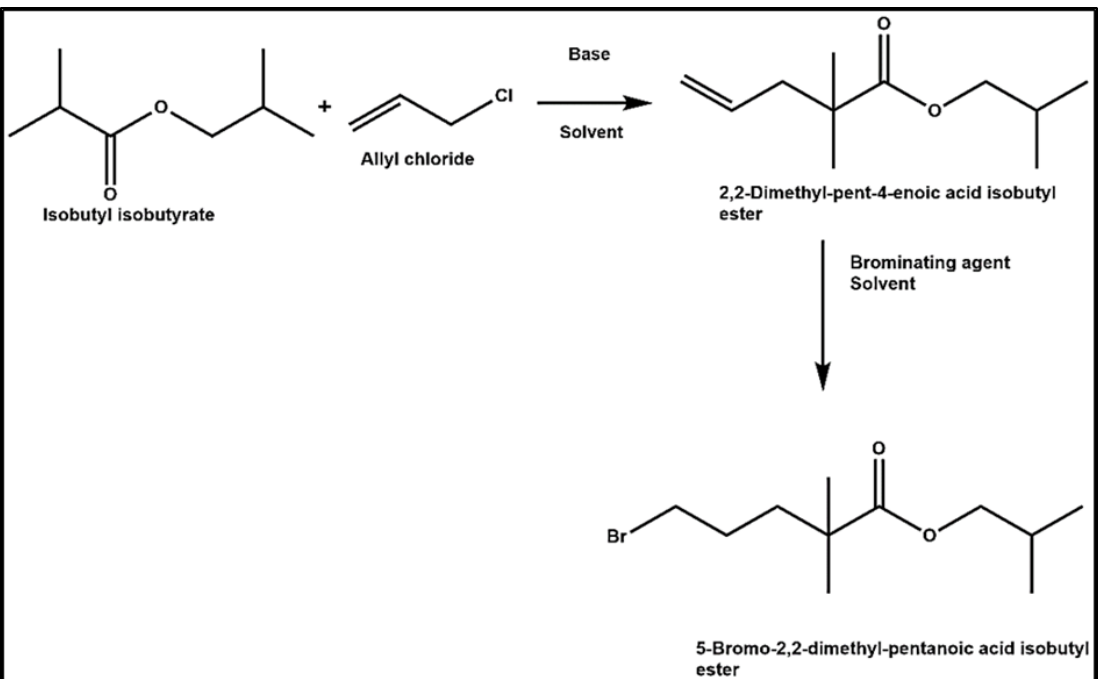
Figure 2. Reaction mechanism for the formation of 5-Bromo-2,2-dimethyl-pentanoic acid isobutyl ester.